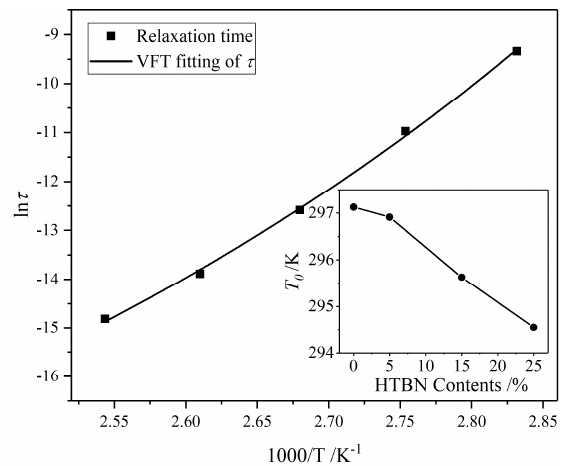
Figure 8. Relationship between relaxation time of epoxy resin α relaxation and reversed temperature. Insert figure: Vogel temperature of α relaxation with different HTBN contents.